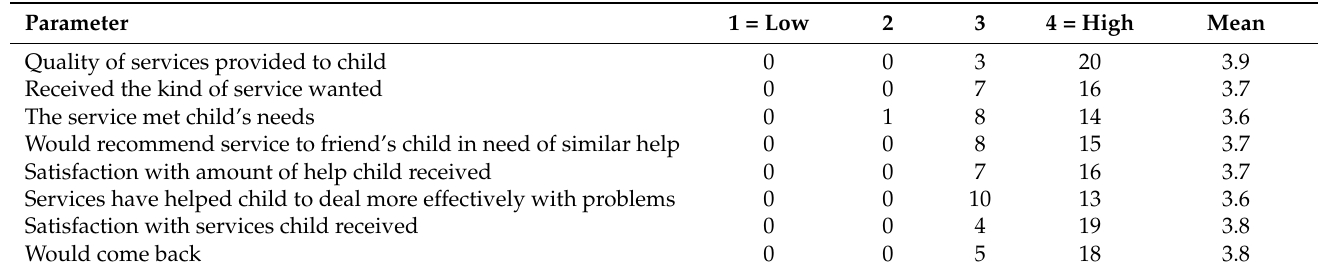
Table 5. Post-appointment parent satisfaction with telepractice assessment using the Client Satisfaction Questionnaire-8 ( n = 23) [39,40].